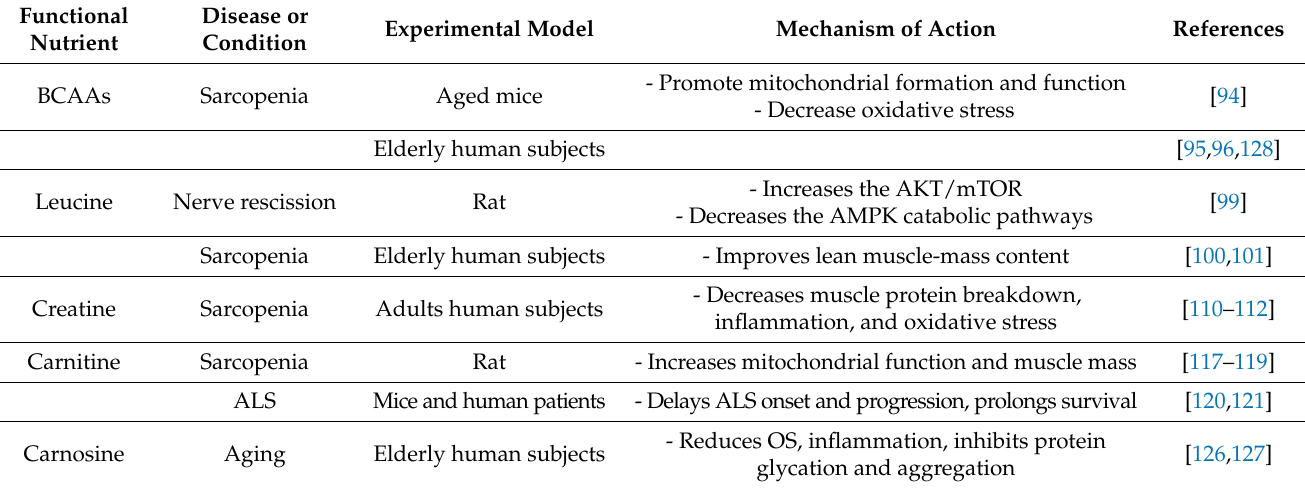
Table 1. Amino acids or peptides able to counteract neurogenic muscle